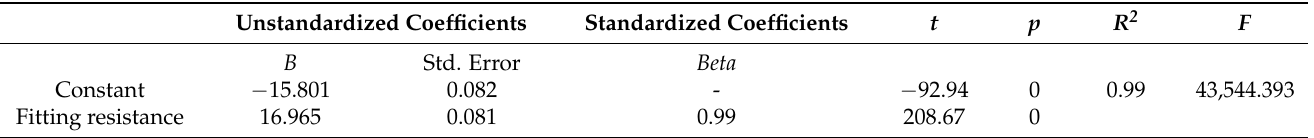
Figure 10. Comparison of actual resistance and topology equivalent resistance model calculation results. Table 3. Parameter Estimates for topology equivalent resistance model.